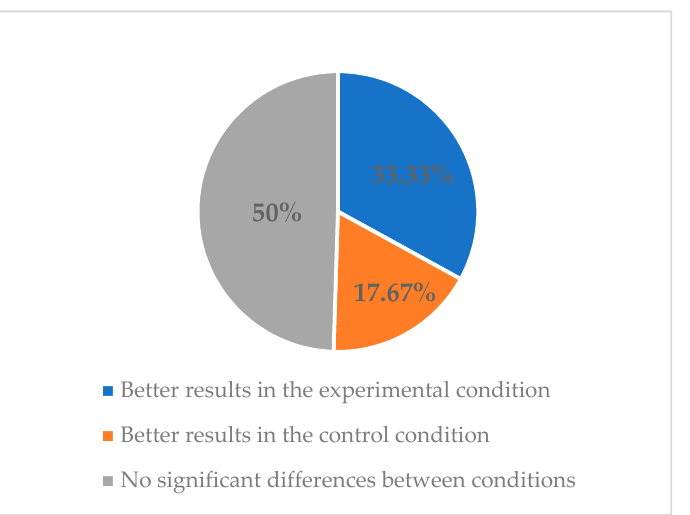
Figure 2. Classification of articles with strong methodological quality based on the abstinence results obtained.